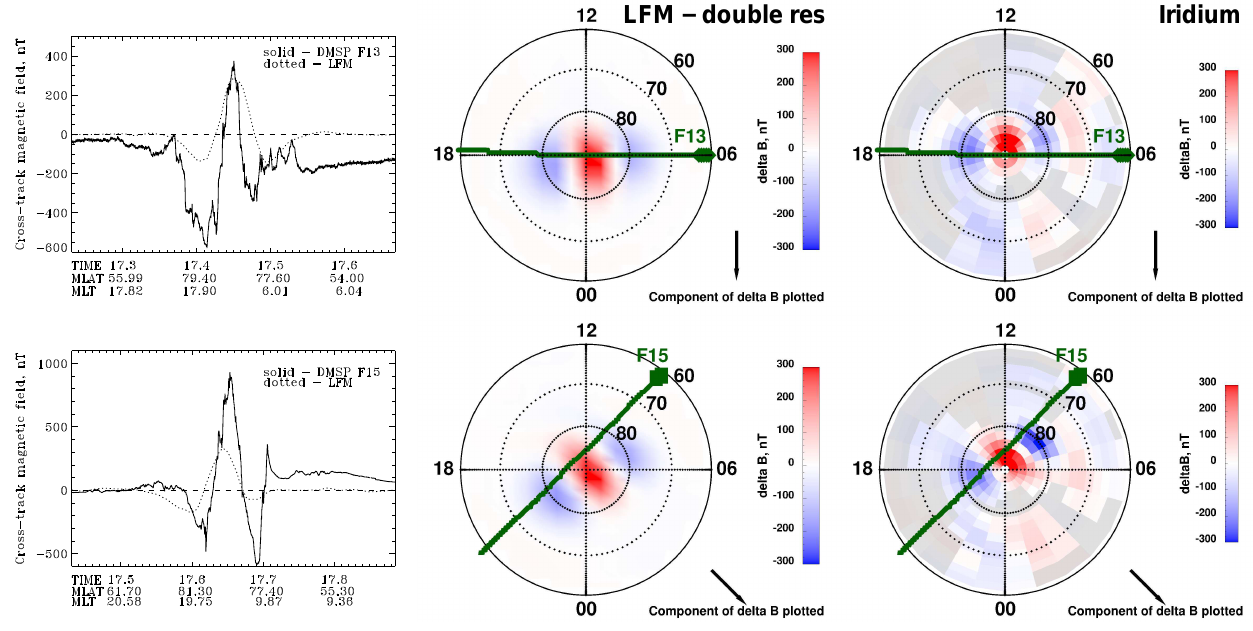
Fig. 3. Comparison of the cross-track magnetic perturbations measured by DMSP F13 (first panel) and F15 (second panel) satellites with double resolution LFM simulations for the polar passes during 17:14–17:40 UT and 17:26–17:53 UT, respectively. The polar plots in the second column show the satellite trajectories plotted over the LFM-simulated magnetic perturbation component in the direction shown in the bottom right corner of the plot (see text for details). The third column has the same format as the second one but the LFM-simulated magnetic perturbations are replaced by those inferred from Iridium observations. In Iridium plots, cells where the magnetic perturbation magnitude is within two standard deviations from zero are shaded gray.